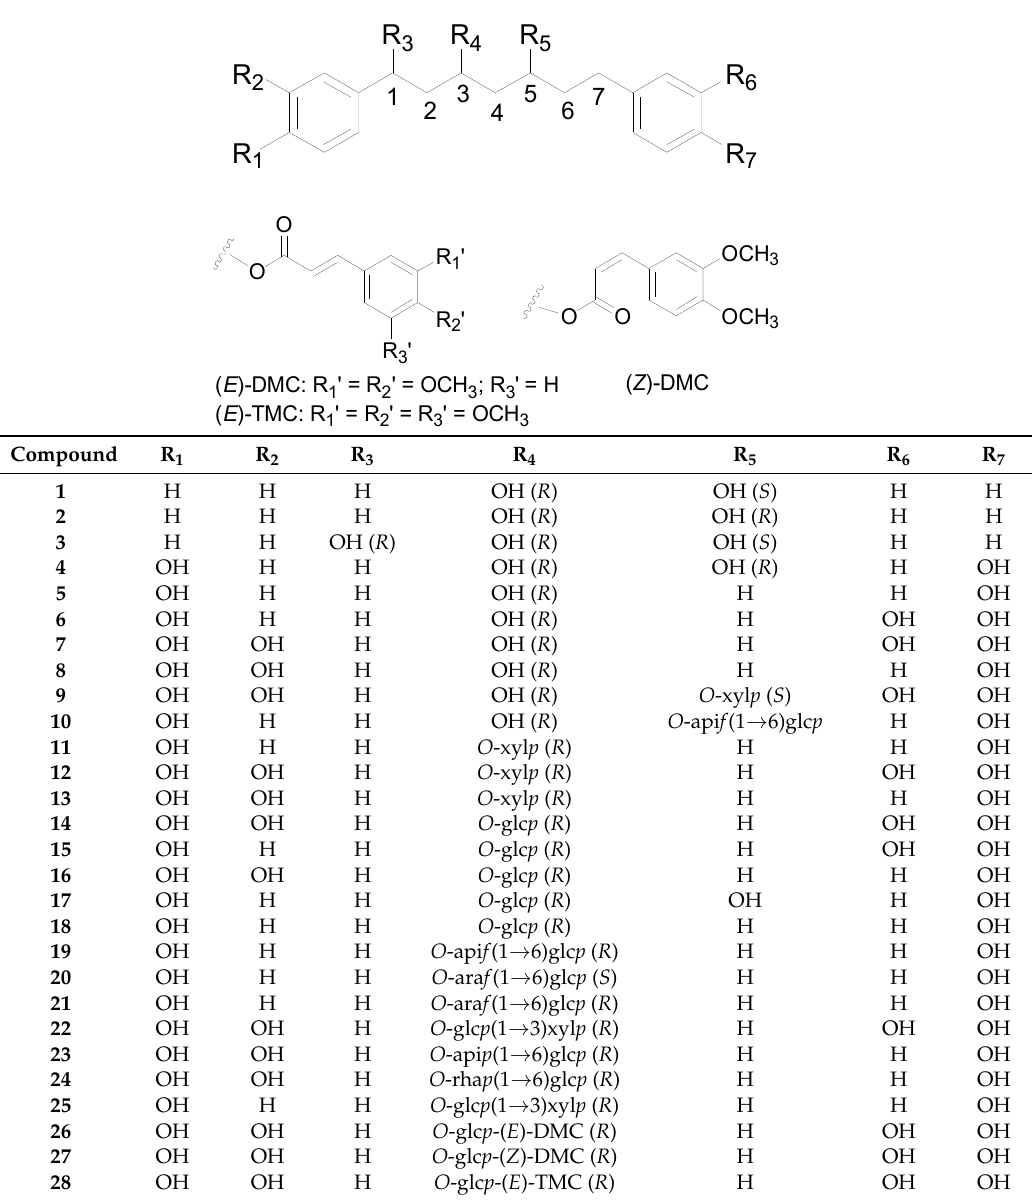
Table 1. Structures of compounds 1 – 28 .